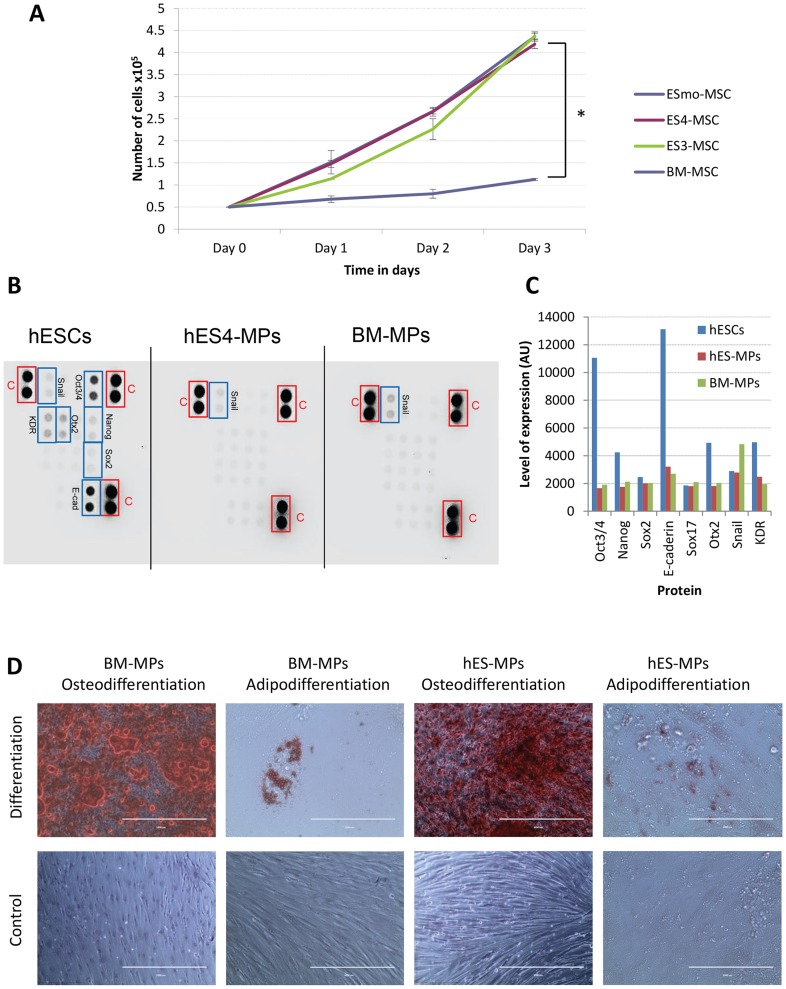
Mesodermal progenitor characterization of hESC derived MPs.A. Growth kinetic comparison over 3 days between BM-MPs and hESC-MPs derived from 3 different hES cell lines (*: p<0.05). B. Pluripotential stem cell array was used to compare protein extracts from hESCs, hES4-MPs and BM-MPs. C. Charts representing the results of the stem cell array. D Phase contrast imaging of the differentiation of hESC-MPs in different mesodermal lineages. Osteoblast were stained using Alizarin Red S and adipocyte with Oil Red O.